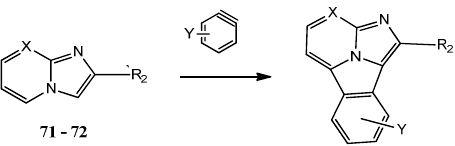
Table 18. Substituents and yields of reaction of azaindolizines and benzynes (Scheme 36). N R2